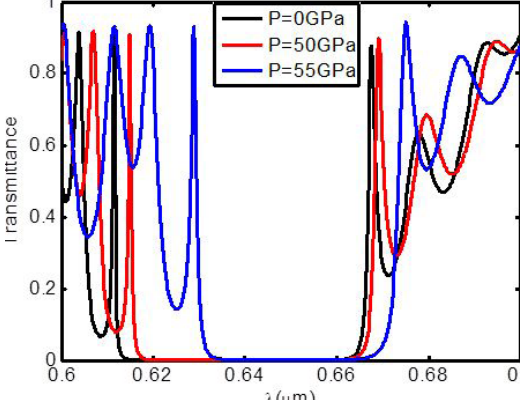
Figure 9. Transmittance spectra for quasi-periodic 1DPC at different values of applied pressure with fixing the other parameters at d2=0.1µm, d3=0.08µm, and